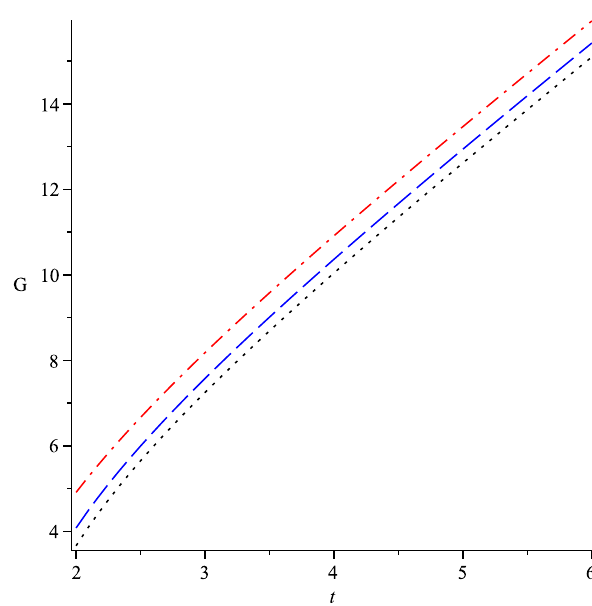
Fig. 8 Graphical representation of G vs t for γ = 0